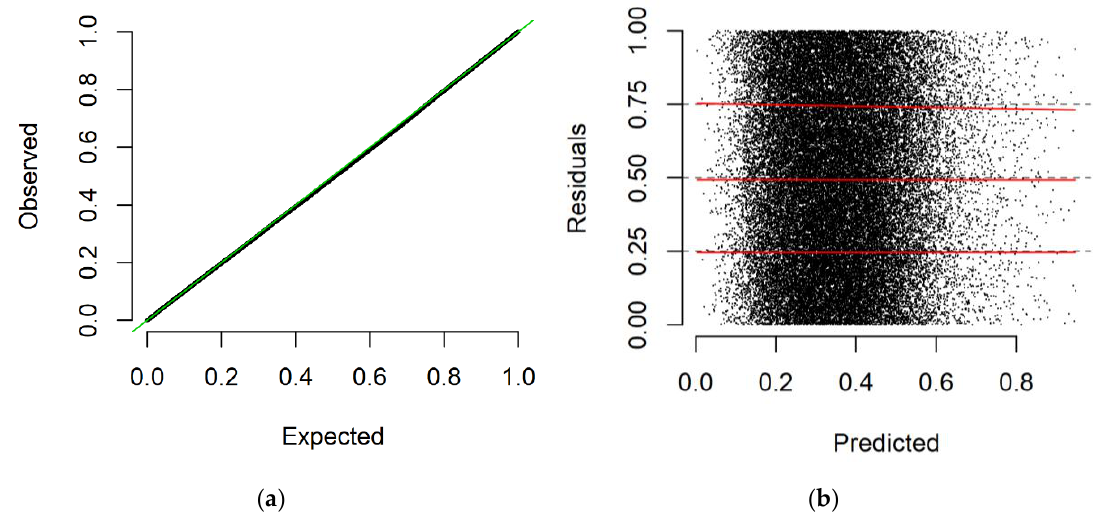
Figure A4. ( a ) Quantile-quantile plot (QQ-plot) for the generalized linear mixed model (GLMM). The QQ-plot can be used to detect overall deviations from the expected distribution (green line). ( b ) GLMM residuals in relation to predicted values. In a well-fitted model, the results of the quantile regression (red lines) should be straight, horizontal, and at y-values of 0.25, 0.5 and 0.75 as indicated by the black dashed lines [58]. The two plots were generated from a synthetic data set within the diagnostic for hierarchical regression models (DHARMa) approach.